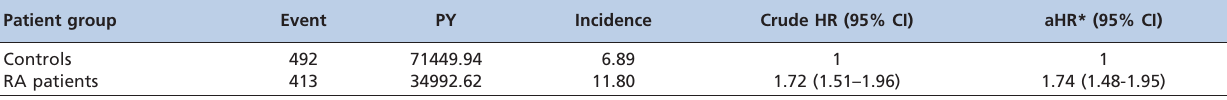
Table 2 - Crude and adjusted hazard ratios of depression for RA patients compared with non-RA controls. Patient